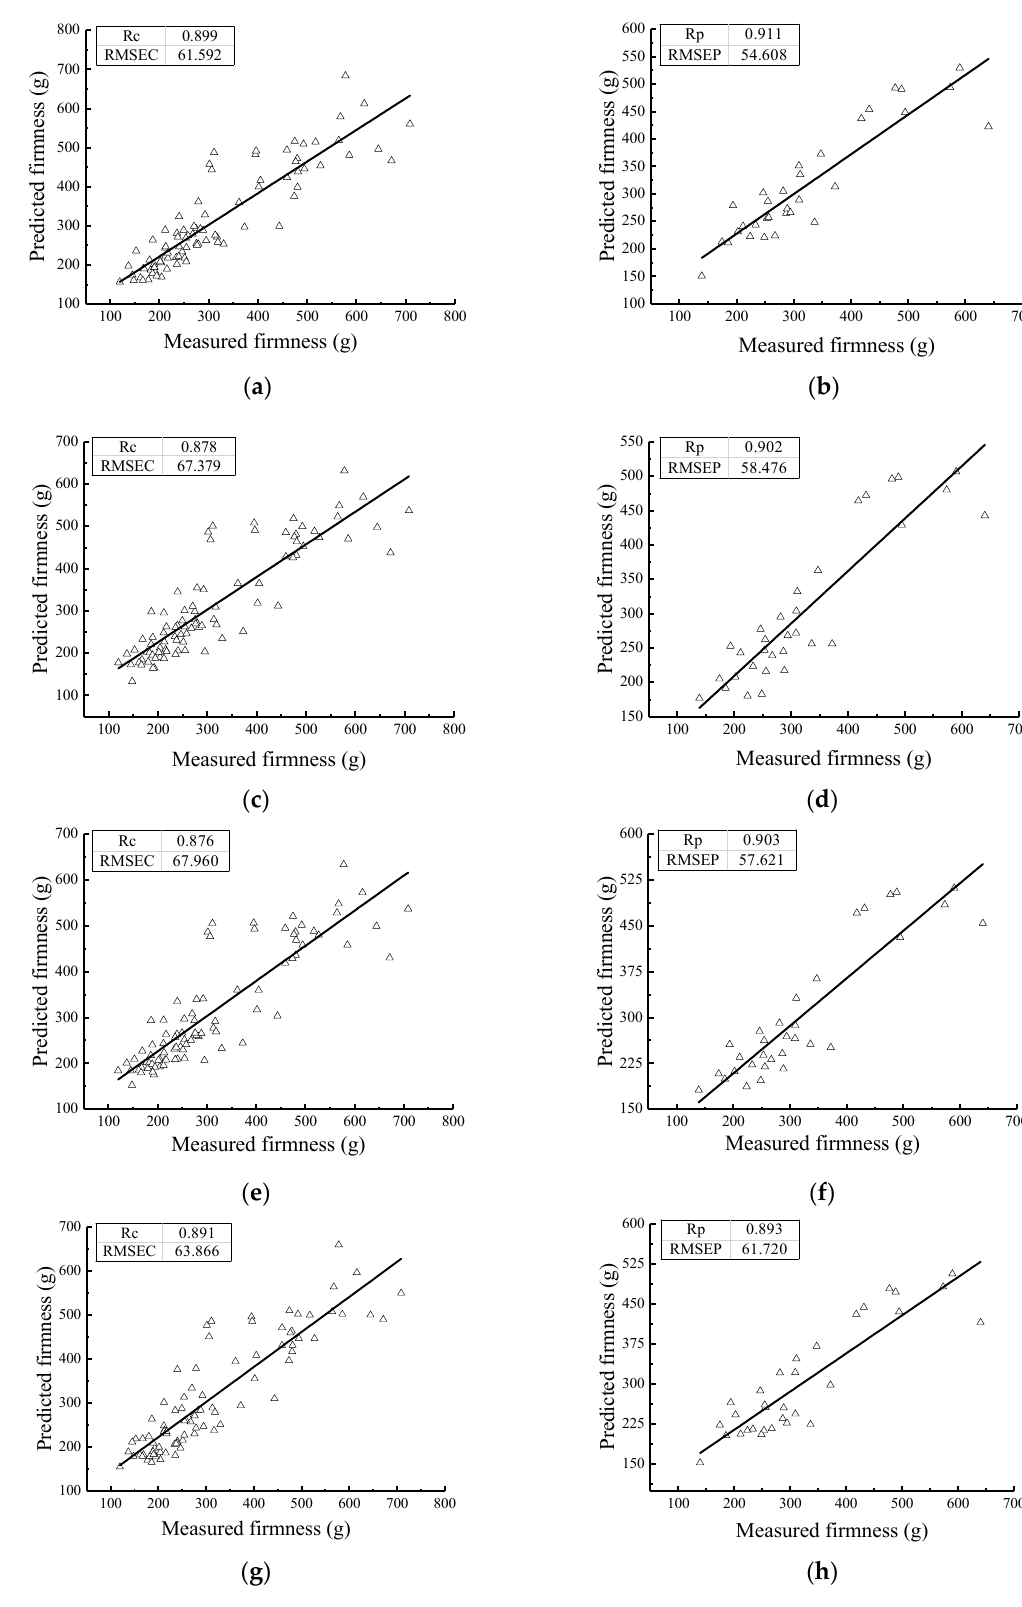
Figure 9. Prediction results of the firmness of pears using the PLS method with different cooling rates: ( a ) the MSC calibration set; ( b ) the MSC validation set; ( c ) the S-G-MSC calibration set; ( d ) the S-G-MSC validation set; ( e ) the S-G-SNV calibration set; ( f ) the S-G-SNV validation set; ( g ) the SNV calibration set; and ( h ) the SNV validation set.